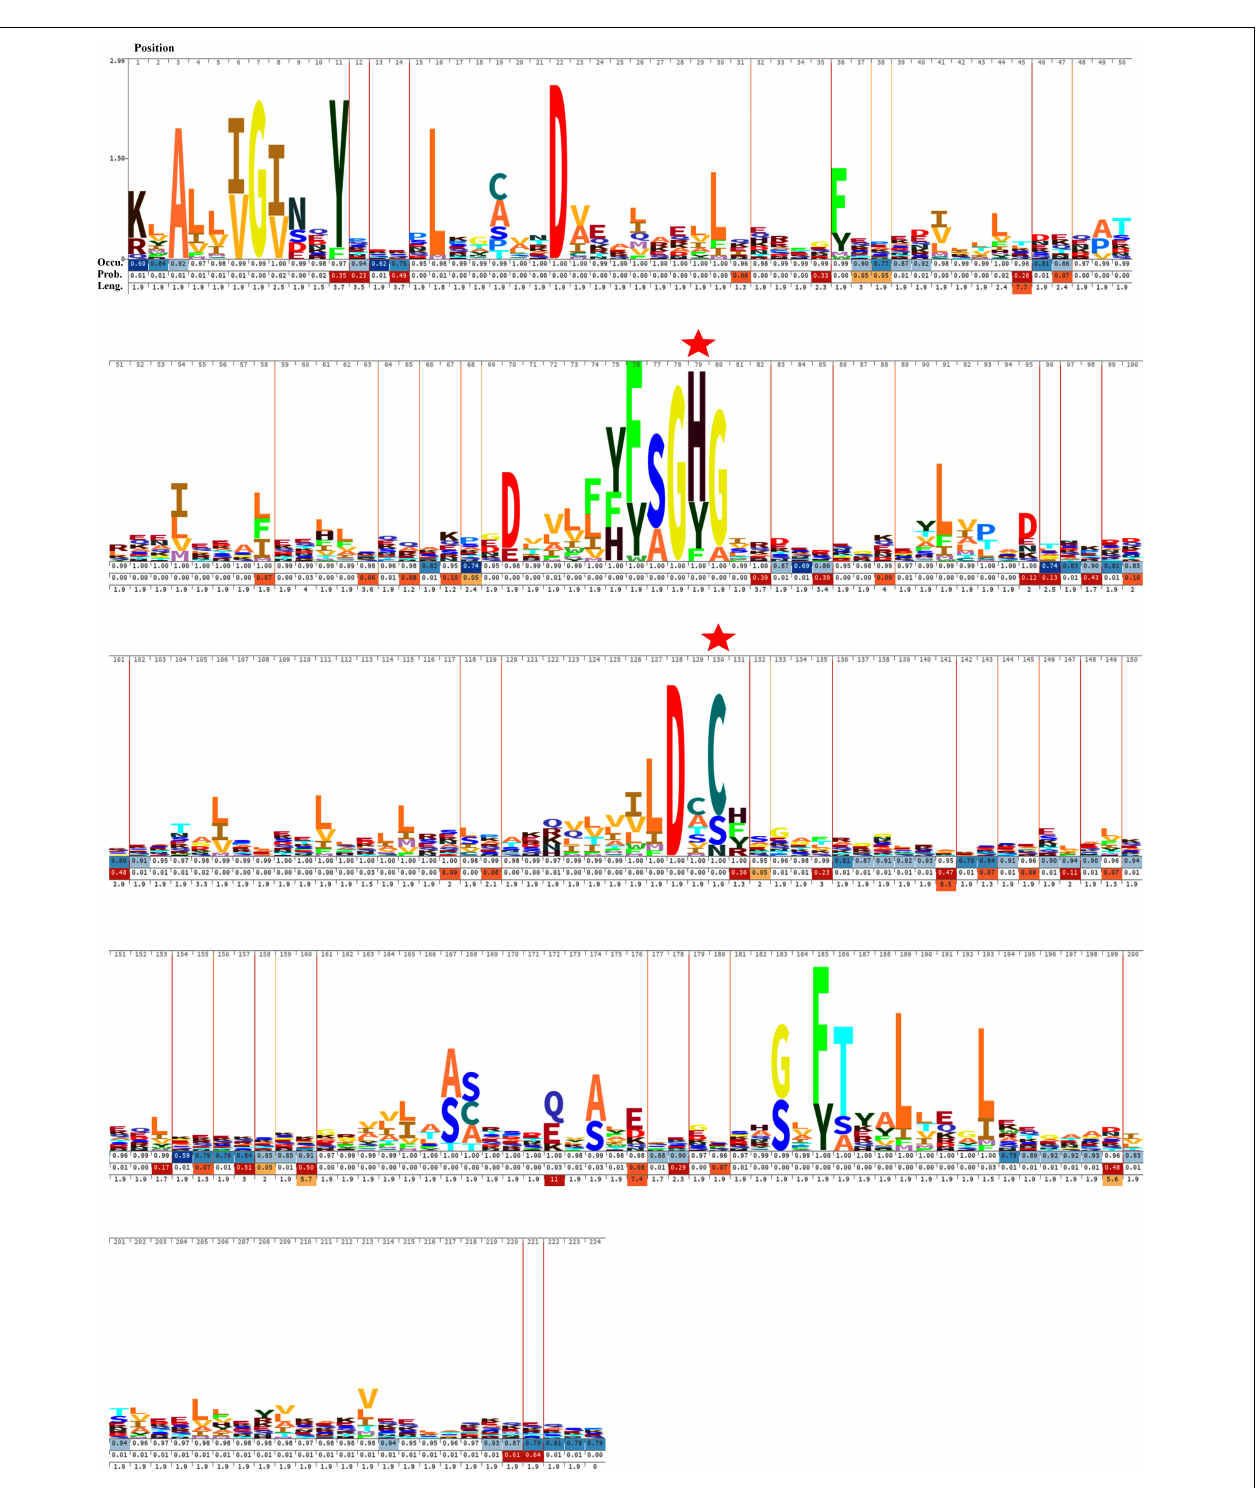
FIGURE 3 | Hidden Markov Model (HMM) logos of the Peptidase C14 domain of putative cyanobacterial orthocaspases. Logos were built with 473 aligned Peptidase C14 domain sequences using Skylign. The values on the Y -axis correspond to the height of each single-letter amino acid code and reflected the probability of its occurrence at that specific position. The larger letter size indicates conserved residues among the protein sequences. The position of each amino acid residue is indicated at the top. The gap parameters, i.e., occupancy (Occu), insert probability (Prob.), and insert length (Leng.), are shown below each residue. The catalytic residues are indicated by “